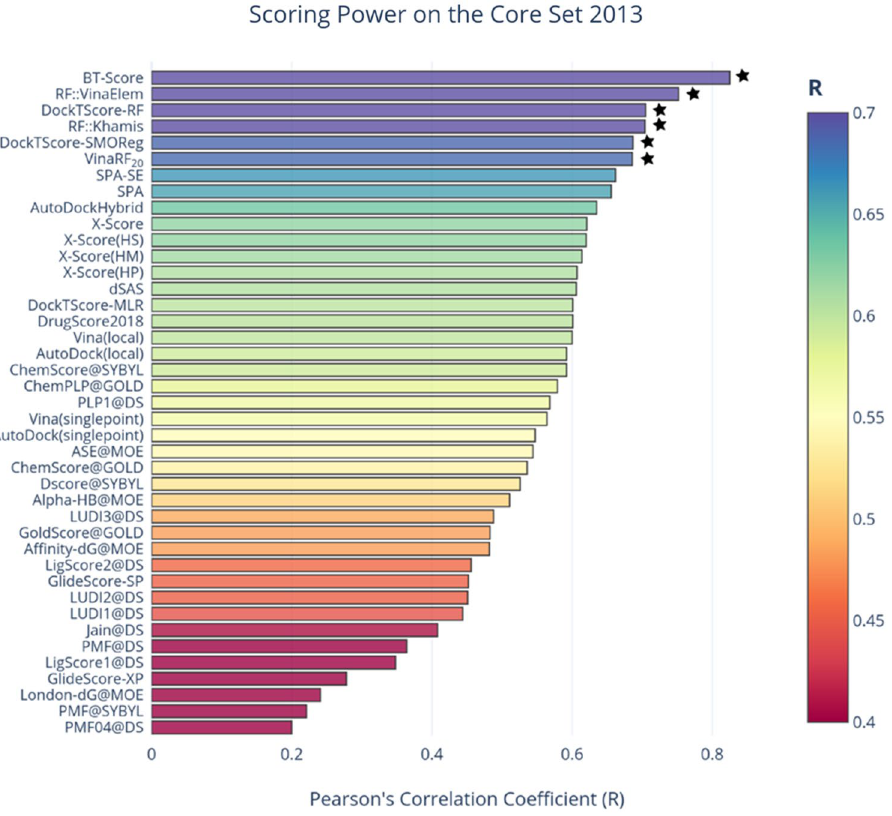
Figure 10. Scoring power of DockTScore linear and nonlinear models compared to the scoring functions evaluated on the core set 2013. Performances collected from the literature: BT-Score 75 , CompSPA 76 , AutoDockHybrid 23 , and the remaining were recalculated from raw data in the recent work of T. Gaillard 77 . Nonlinear models are highlighted with a star. Scoring functions with Pearson’s correlation coefficients higher or equal than 0.7 are colored purple and those lower than or equal to 0.4 are colored